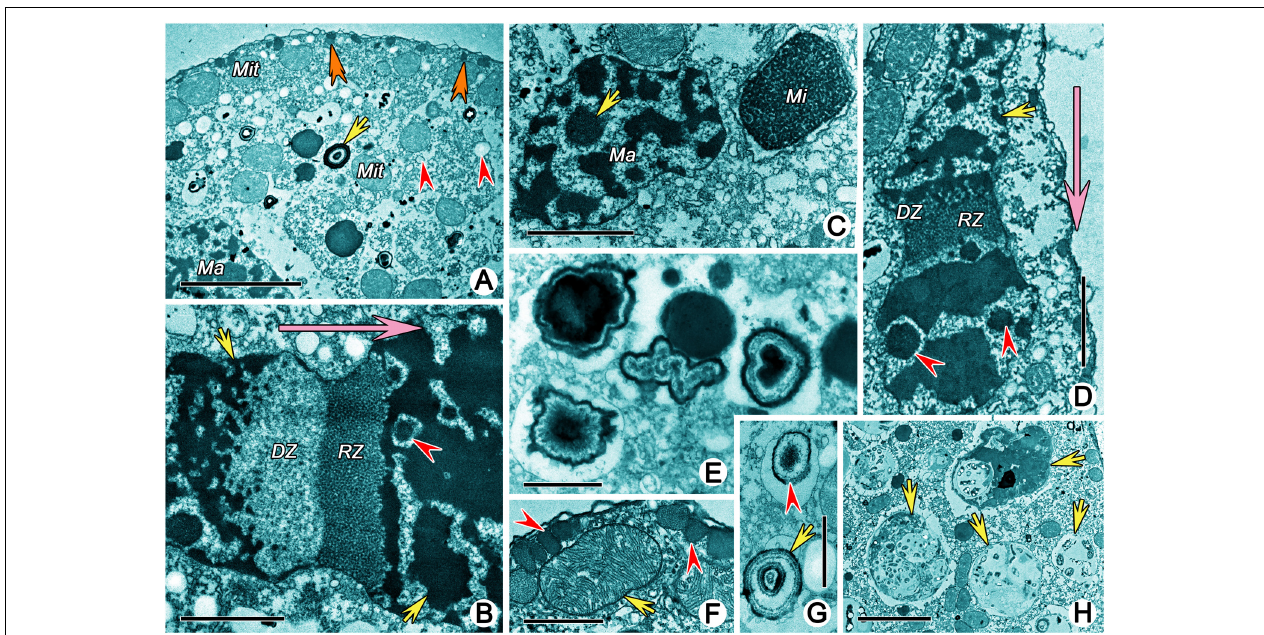
FIGURE 7 | Transmission electron micrographs showing structures in cytoplasm of Uronychia binucleata . (A) Cytoplasm and cytoplasmic organelles. Arrow marks the lithosome, arrowheads point to vesicles, double-arrowheads indicate the extrusomes. (B,D) Replication band is composed of a reticular zone (RZ) and a diffuse zone (DZ). Arrowheads point to nucleoli, arrows mark chromatin bodies, big arrows indicate the movement direction of the replication band. (C) Macronuclear nodule and micronucleus. Arrow marks the nucleolus. (E) Various shaped concentric concretions which might be lithosomes. (F) Section perpendicular to pellicle showing the micronucleus (arrow) and extrusomes (arrowheads). (G) Lithosome (arrow) and concentric concretions (arrowhead). (H) Food vacuoles containing bacteria. Ma, Macronuclear nodule; Mi, micronucleus; Mit, mitochondria. Scale bars = 5 µ m (A,H) , 2 µ m (B–D) , 1 µ m (E,F) , 0.5 µ m (G) .